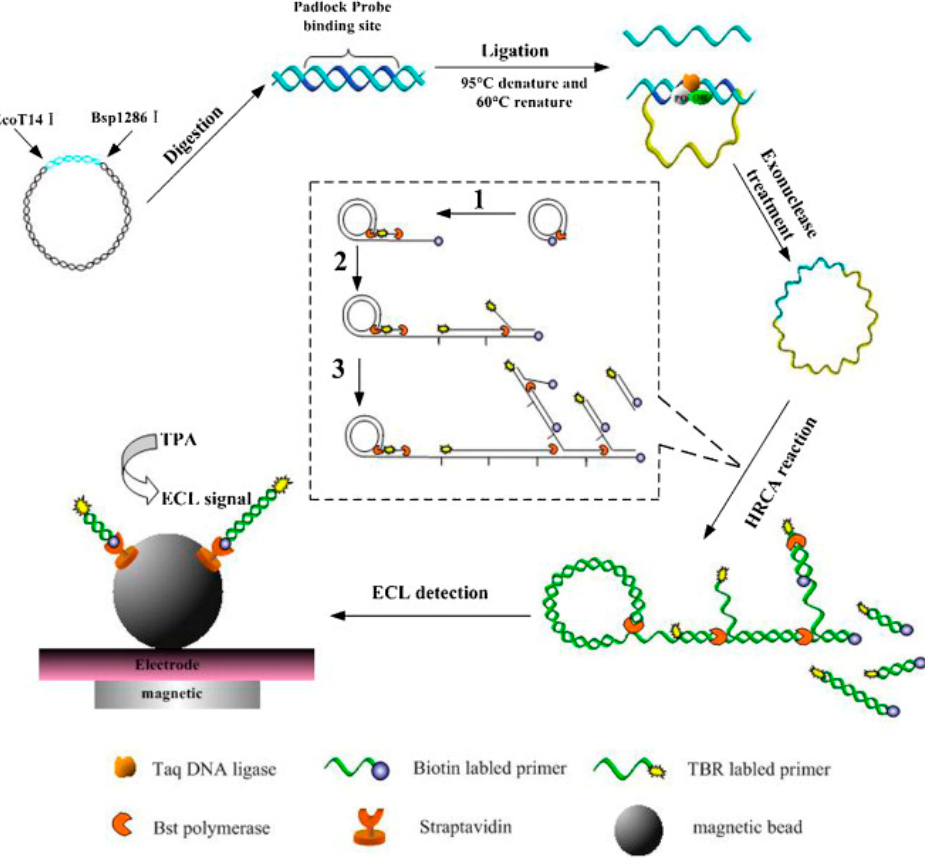
Figure 4. Schematic of isothermal ECL detection of hlyA gene of L. monocytogenes . Reproduced with permission from [66], published by Elsevier B.V, 2011.